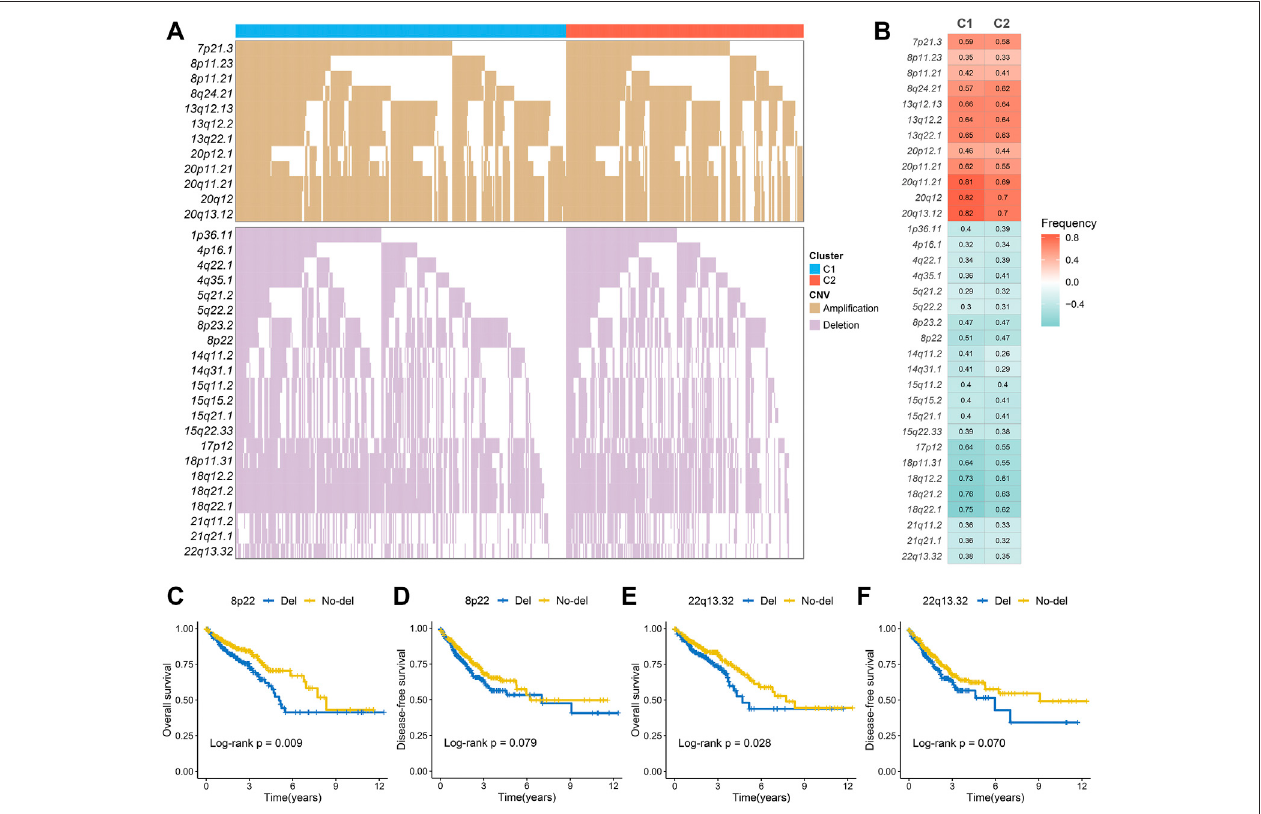
FIGURE 4 | The copy number variations of two immune subtypes. (A,B) The waterfall plot (A) and alteration frequency (B) of signi fi cantly ampli fi ed and loss chromosomal segments in C1 and C2. (C,D) . Kaplan-Meier survival analysis of overall survival (C) and disease-free survival (D) according to the 8p22 deletion. (E,F) Kaplan-Meier survival analysis of overall survival (E) and disease-free survival (F) according to the 22q13.32 deletion.